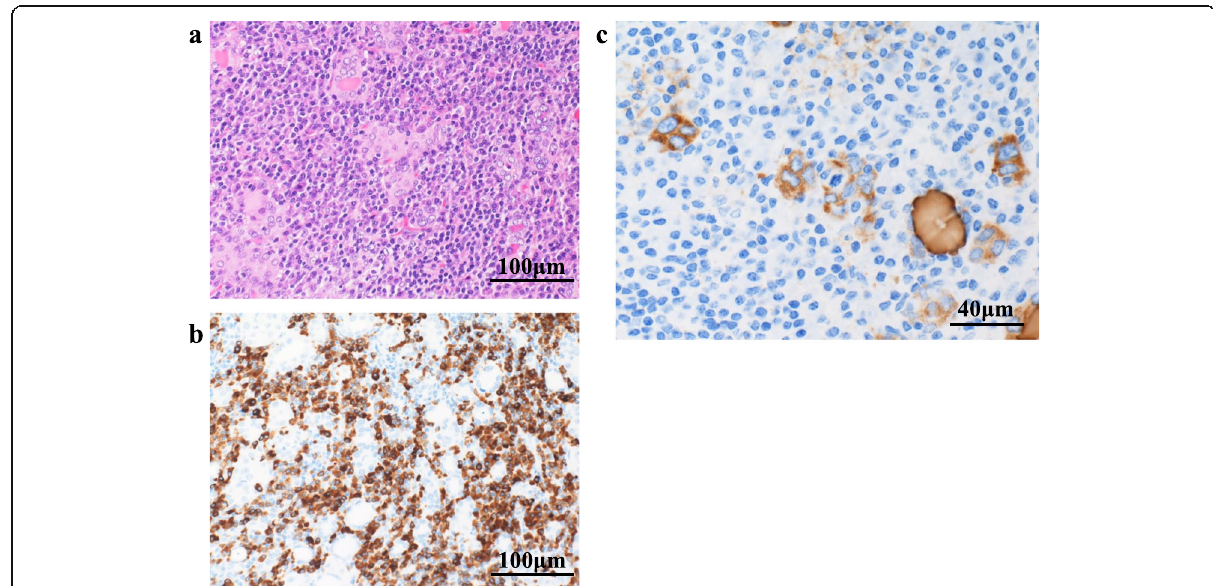
Fig. 4 Histopathological findings of ectopic mediastinal thyroid tissue. A horizontal bar indicates the actual length. a Abundant thyroid follicles and lymphocytes with hematoxylin-eosin staining. b Positive lymphocytes on CD79a staining. c Lymphoepithelial lesion to epithelial cells stained positive for thyroglobulin